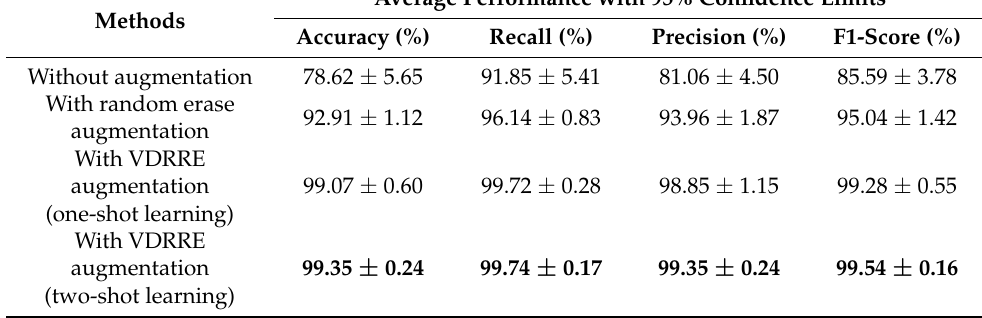
Table 2. Performance of the hybrid classifier for palsy recognition with respect to the use of the pro- posed image augmentation method. Best results are shown in bold. VDRRE, Voronoi decomposition- based random region